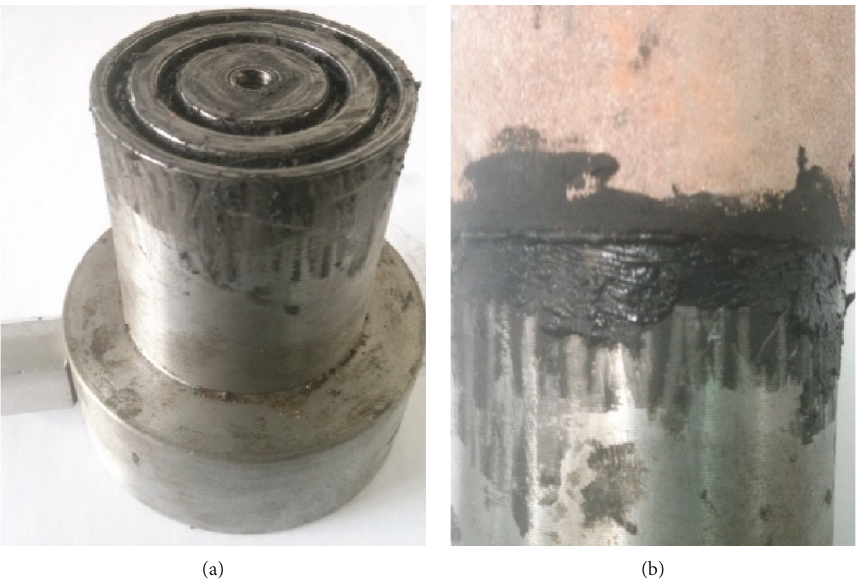
Figure 4: Sealing of the specimen. (a) Platen. (b) Specimen bonded with platen.